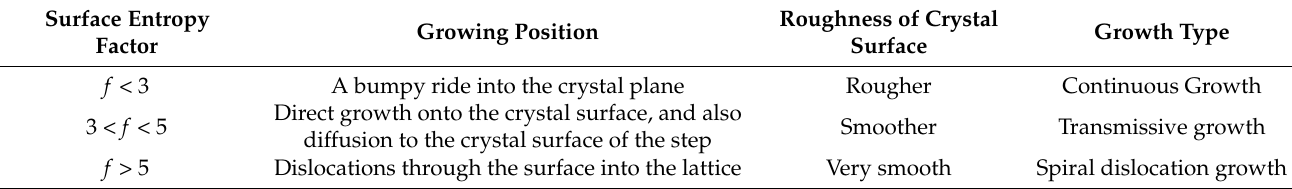
Table 3. Relationship between surface entropy factor and crystal